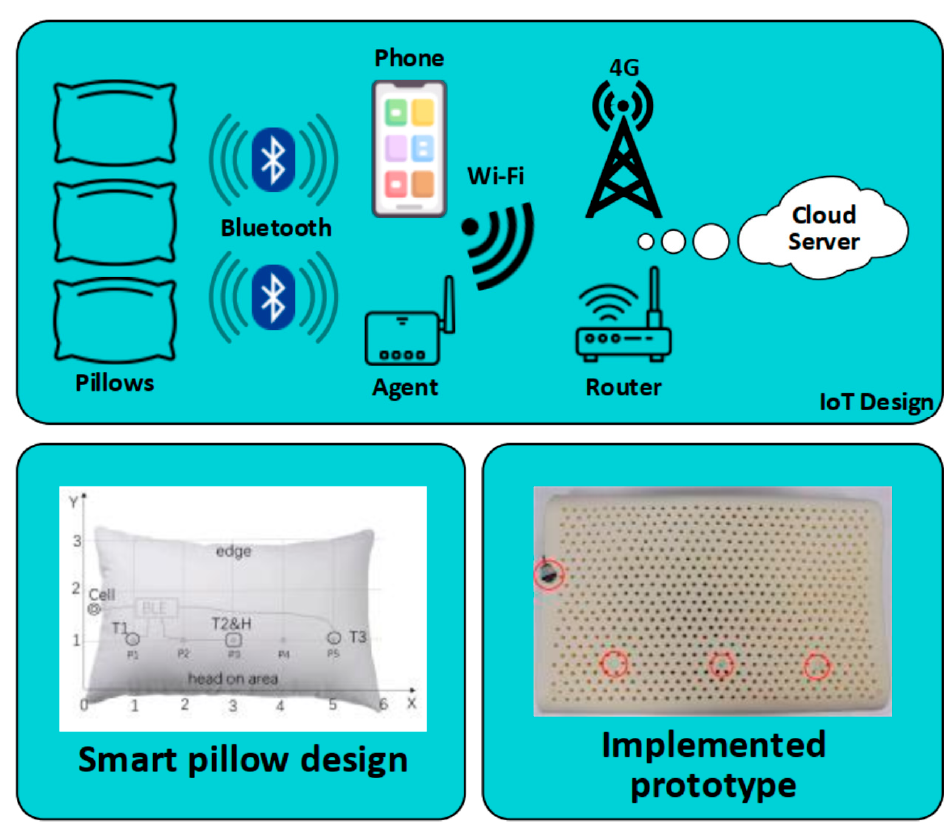
Figure 11. Smart pillow structure for temperature sensing (modified from [64]).